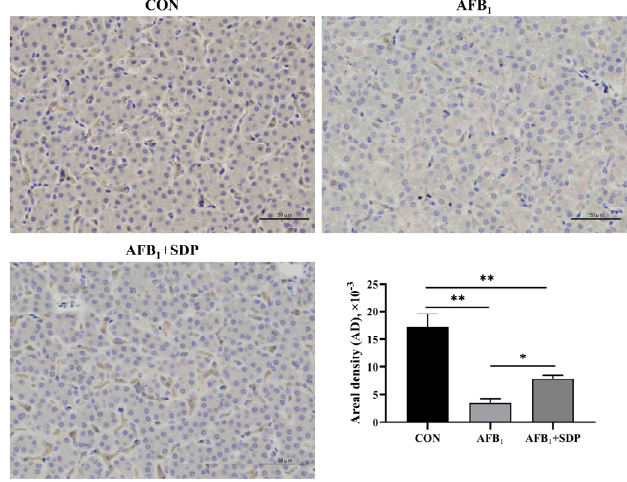
Figure 6. The protective effects of dietary seaweed ( Enteromorpha prolifera )-derived polysaccharides on hepatic Nrf2 protein expression in broiler chickens based on immunohistochemical analysis. * p < 0.05, ** p < 0.01, no superscript marks indicated that p > 0.10. CON: control group; AFB 1 group (fed diet with 0.1 mg/kg AFB 1 ); AFB 1 + SDP group (AFB 1 group + 0.25% SDP). The Western blotting results are presented in Figure 7. AFB 1 exposure reduced the protein expression level of p38MAPK, total Nrf2 and nuclear Nrf2 in the liver ( p < 0.05). Inclusion of SDP in the diet could increase the protein expression level of p38MAPK, total Nrf2 and nuclear Nrf2 in the liver ( p < 0.05).